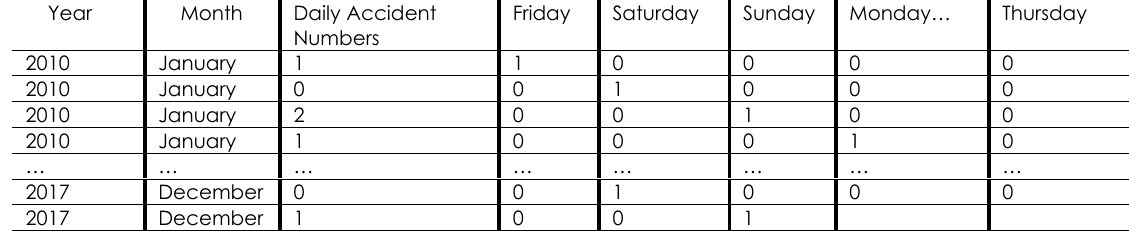
Table 4. Showing data entry in excel in the model established to determine whether there is a day effect on the